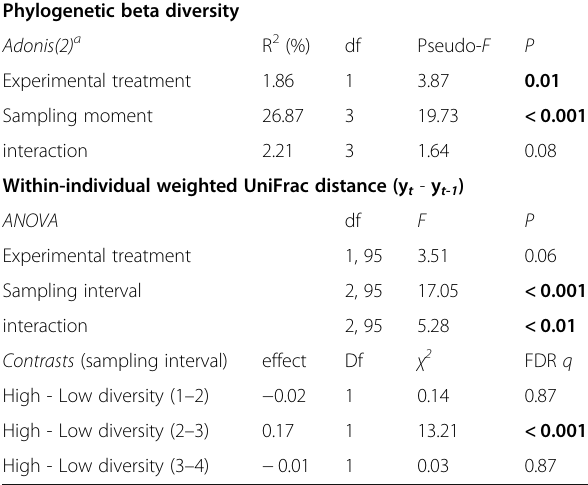
Table 4 Adonis2 and linear mixed model statistics of experimental and temporal effects on phylogenetic beta diversity Phylogenetic beta